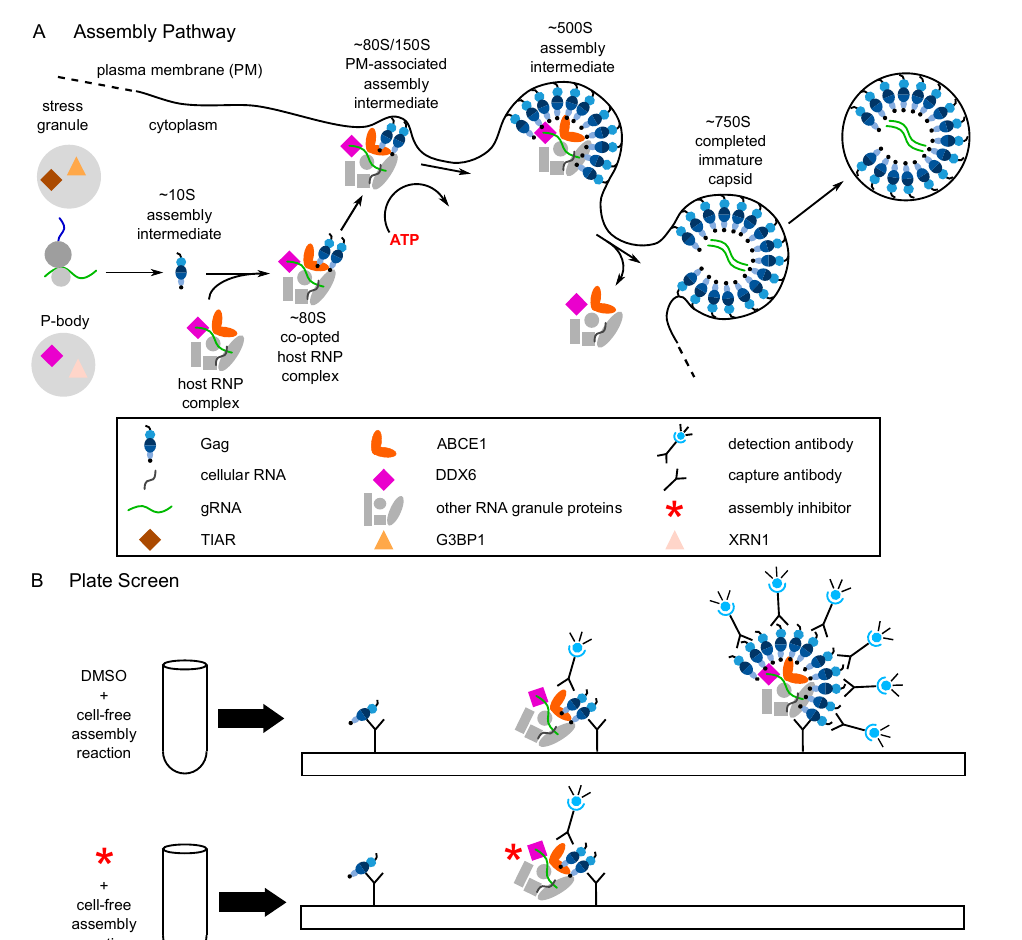
Figure 3. The host-catalyzed HIV-1 assembly pathway was developed into a screen for small molecule inhibitors. ( A ) Schematic showing the host-catalyzed HIV-1 assembly pathway, starting with Gag synthesis and formation of the early ~10S assembly intermediate. The ~80S assembly intermediate is formed when ~10S Gag co-opts a host RNP complex containing ABCE1 and DDX6, two host enzymes that have been shown to facilitate assembly. The co-opted host RNP complex is distinct from but related to P-bodies and stress granules, which are larger host RNP complexes. The ~80S assembly intermediate targets to the plasma membrane where Gag multimerization continues, resulting in sequential formation of the ~150S and ~500S assembly intermediates and the fully assembled ~750S immature capsid. Upon completion of assembly, the host RNP complex is released. Relevant references are in the text. ( B ) A cell-free protein synthesis and assembly plate screen that recapitulates the host-catalyzed HIV-1 assembly pathway was developed and utilized to identify small molecule inhibitors of the pathway [29]. In this screen, a capture antibody directed against Gag binds Gag monomers, oligomers, and multimers generated in a cell-free assembly reaction. The same anti-Gag antibody is used as a detection antibody that binds to captured oligomers and multimers, but not monomers whose binding site is occupied. The signal produced by the detection antibody is proportional to the amount of anti-Gag binding with a larger fluorescent signal indicating more extensive multimerization. The upper diagram shows the large signal that is produced when the HIV-1 cell-free assembly reaction is carried out in the presence of DMSO, which does not inhibit Gag assembly. The lower diagram shows inhibition of that signal when an inhibitor of Gag assembly is added at the start of the cell-free reaction. Legend in the middle applies to panels ( A ) and ( B